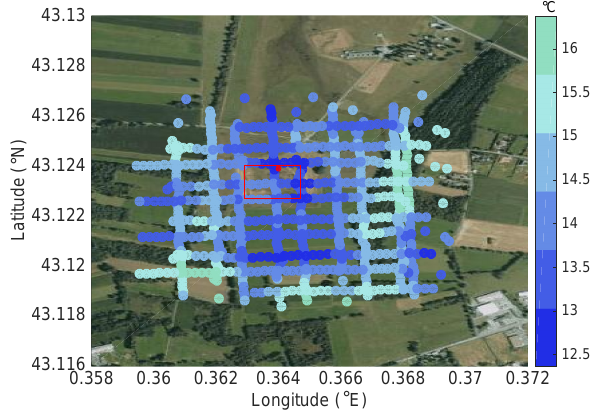
Figure 10. Same as in Fig. 9, but for 2 July 2011 at 17:43UTC.